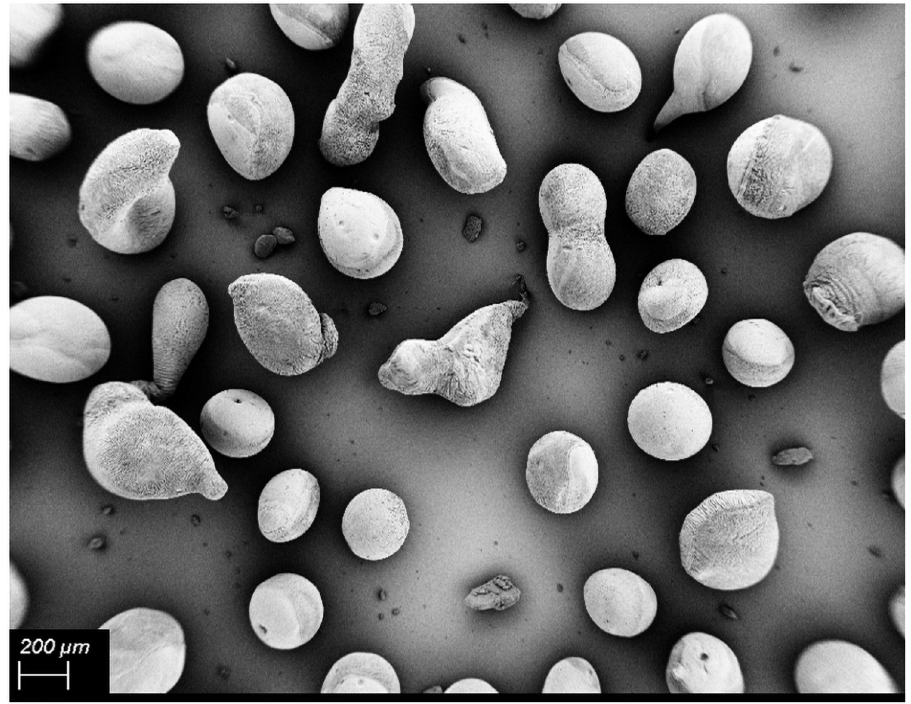
Fig 1. Scanning electron micrographs of Alg aerogel particles which were prepared by a jet cutting process with a subsequent drying step by supercritical CO 2 .